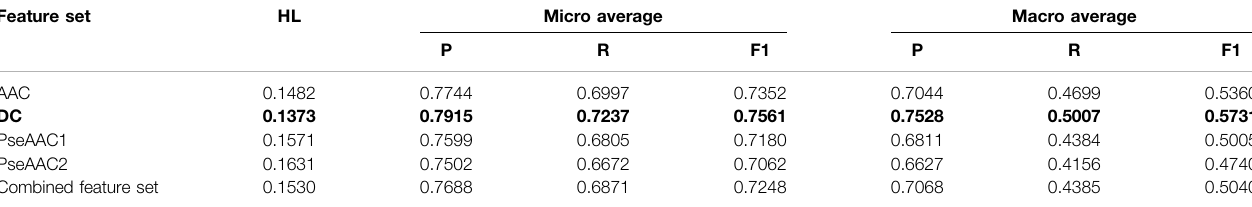
TABLE 3 | Training performance outcome for LP-RF classi fi er (Note that the best performing feature set is shown in bold). Feature